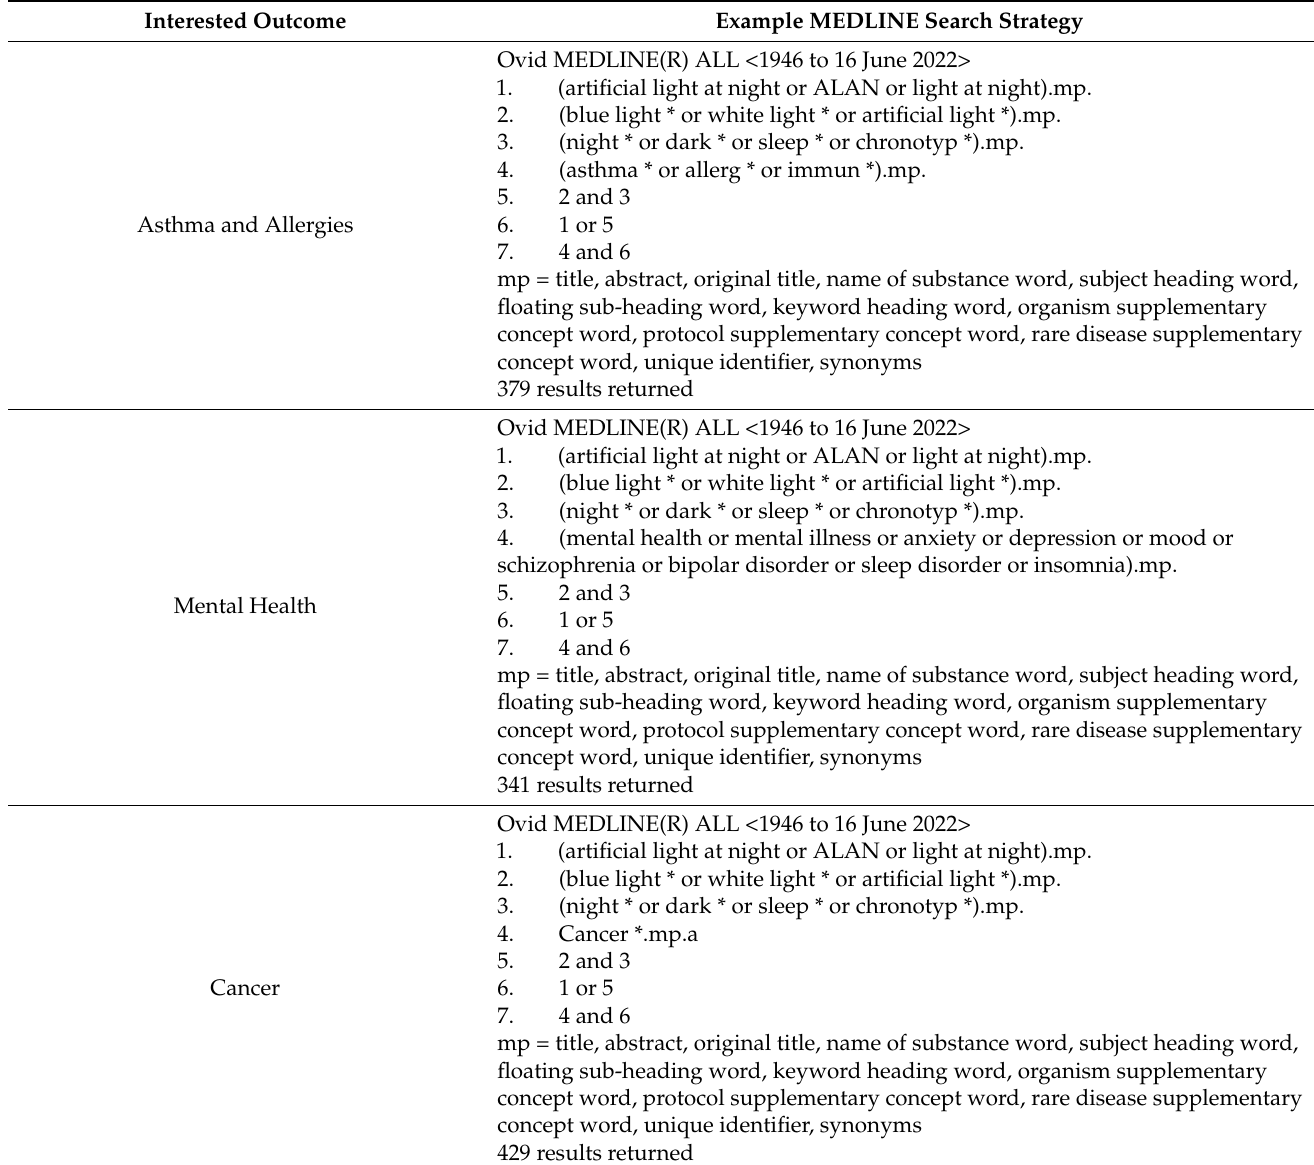
Table 1. Draft MEDLINE search strategies to identify studies for inclusion for the three review outcomes of